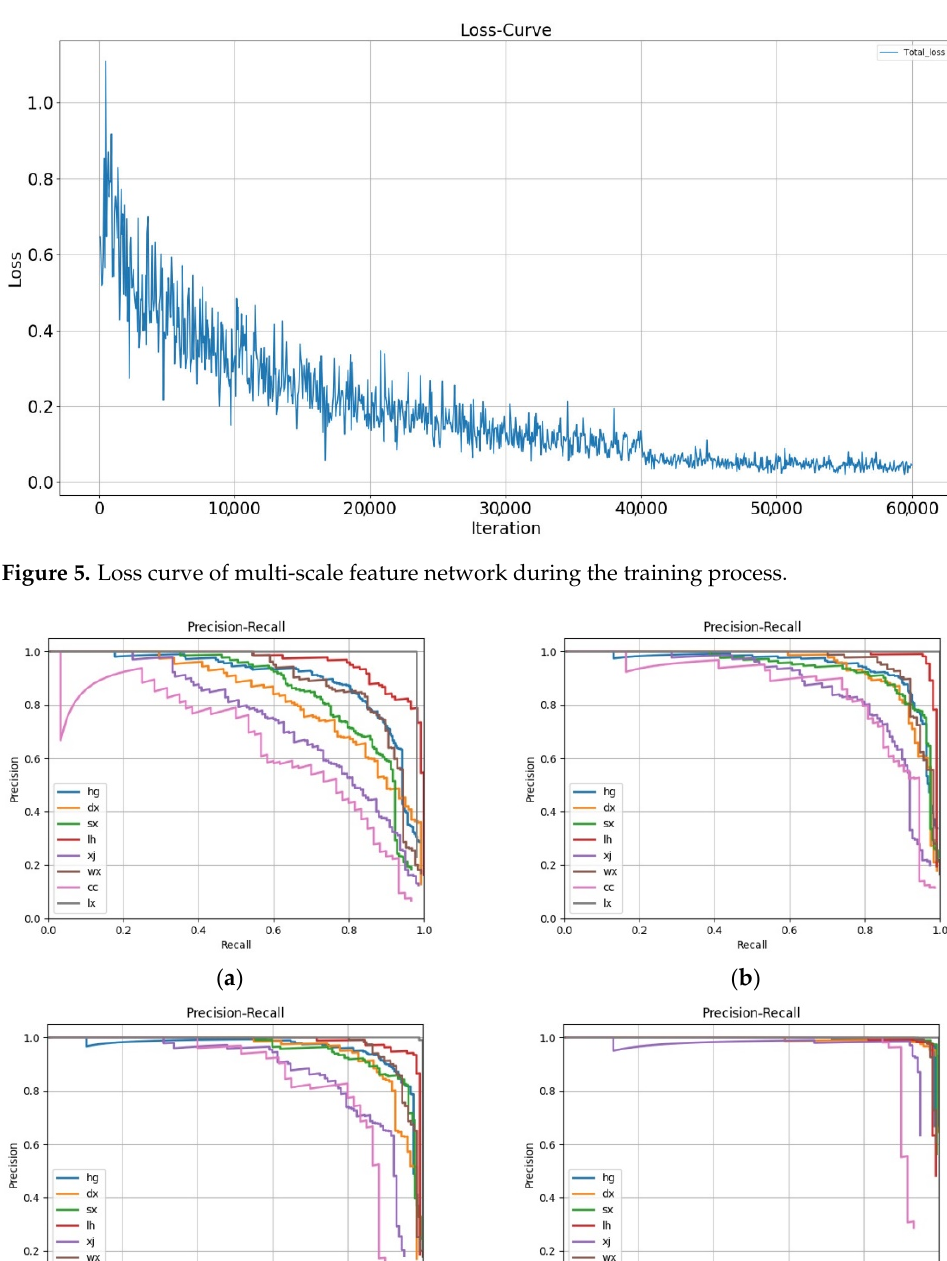
Figure 5. Loss curve of multi-scale feature network during the training process.